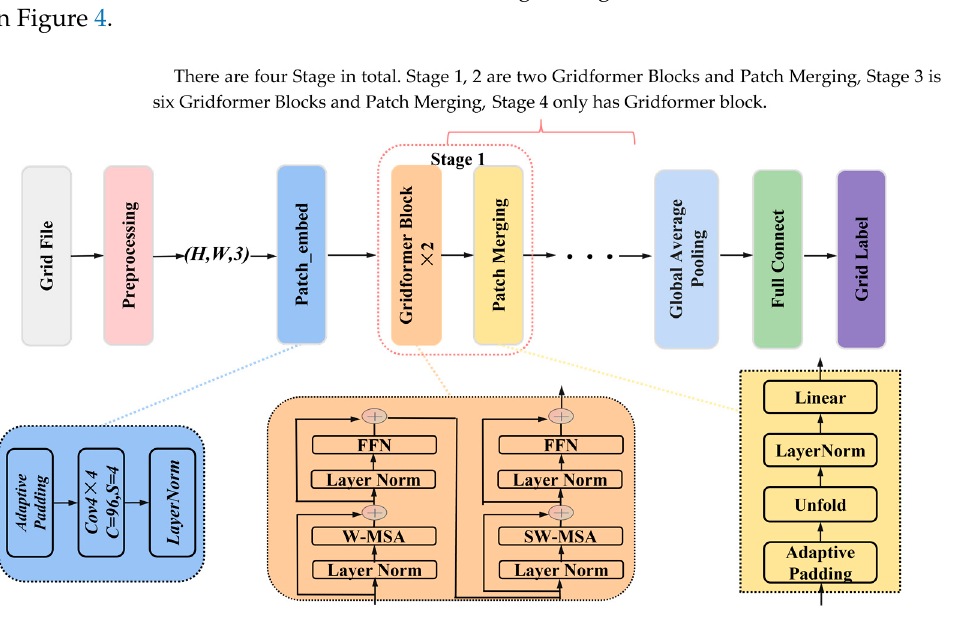
Figure 4. Gridformer, a Transformer-based method for automatic mesh quality evaluation of models. The mesh data is converted into a three-dimensional matrix by pre-processing. The network learns the features between the data and divides the meshes into predefined categories.